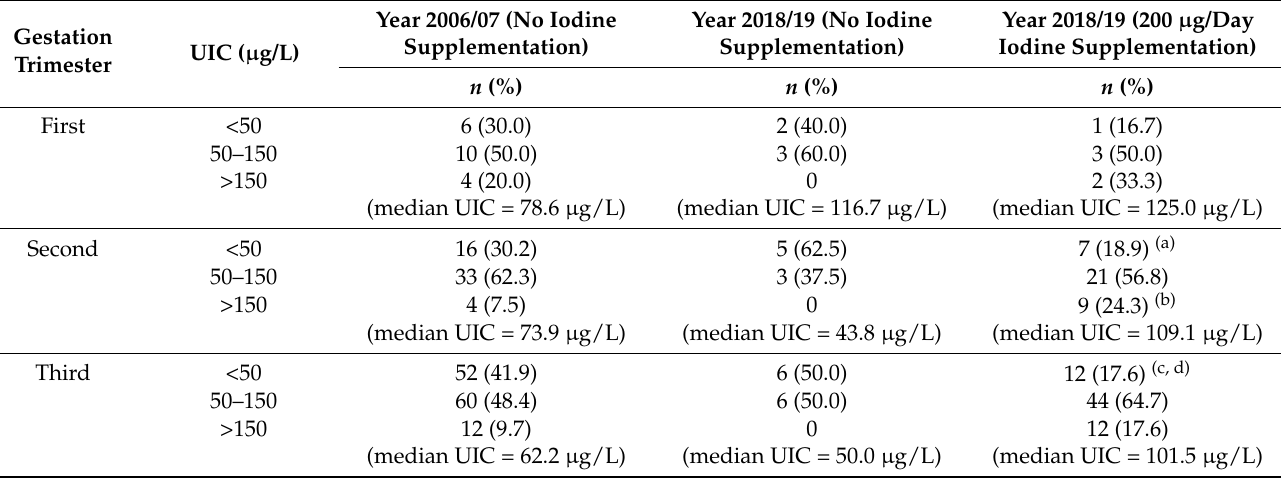
Table 2. Urinary iodine concentration (UIC) according to gestational